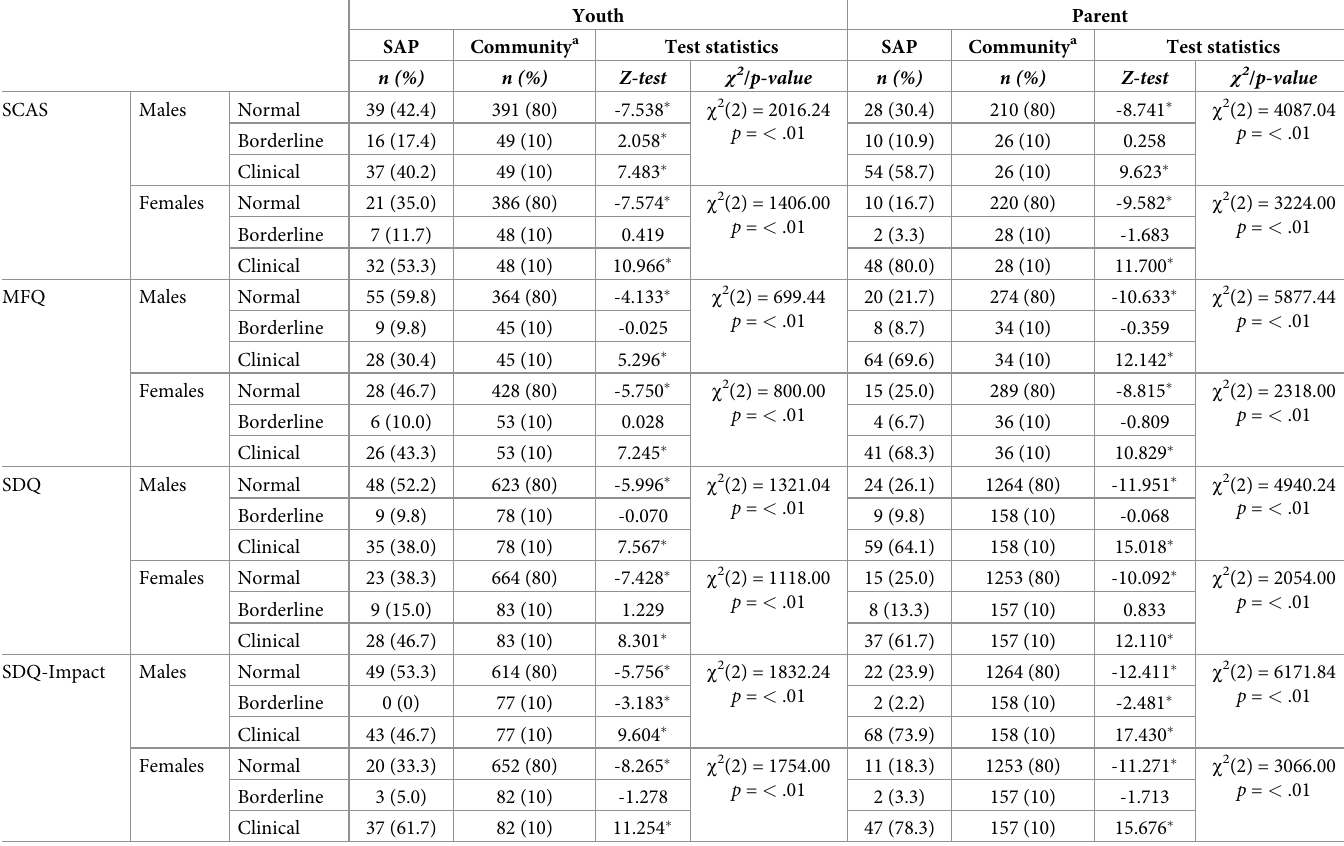
Table 2. Participants with elevated scores on SCAS, MFQ, SDQ-Total and SDQ-Impact, compared with the expected distribution from norm